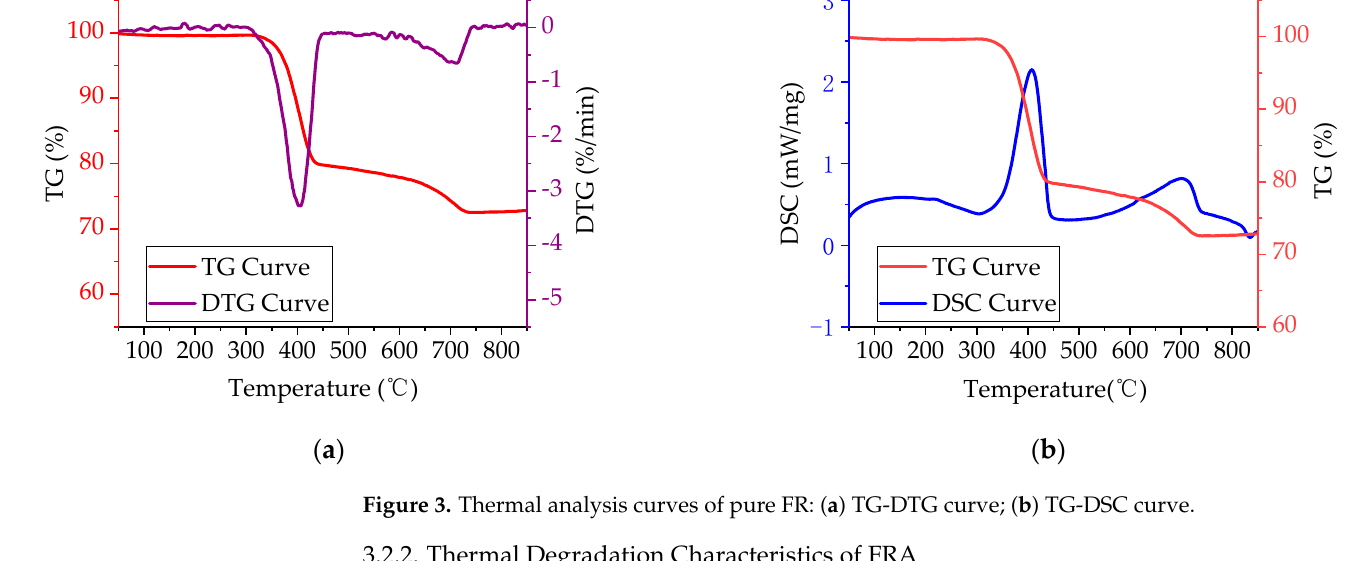
Figure 2. Smoke density rating of FRA.